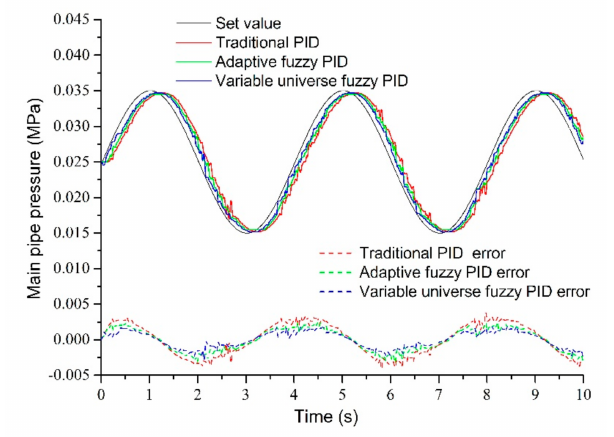
Figure 14. Sinusoidal tracking response